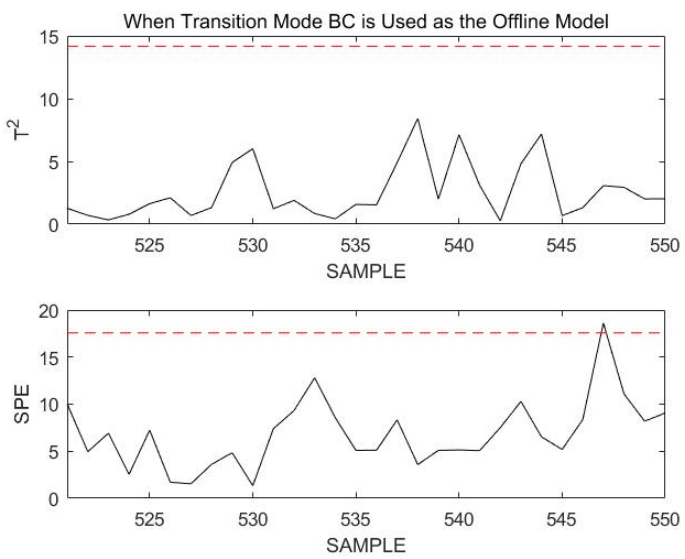
Figure 9. Monitoring 521st to 550th sample points using transition mode BC as an offline model.